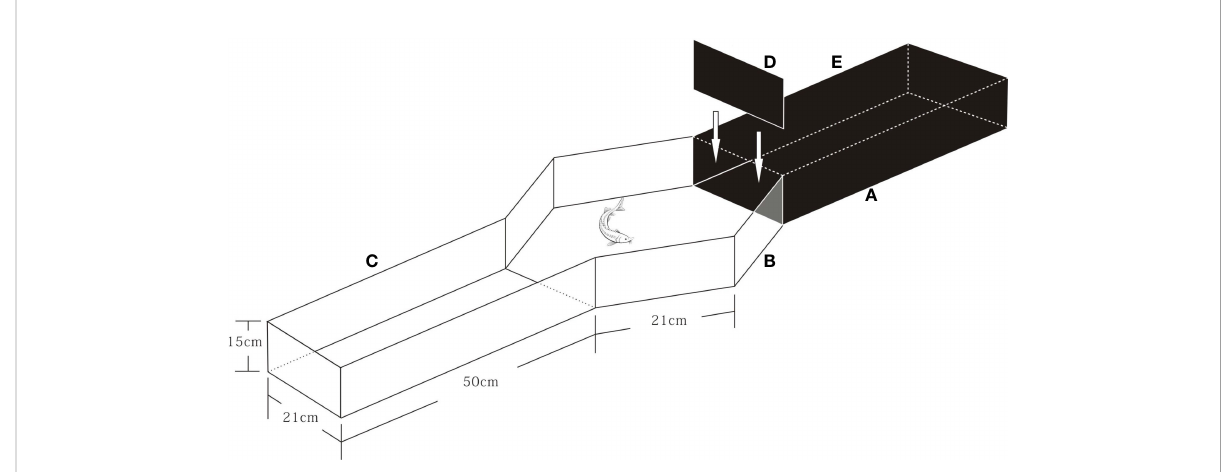
FIGURE 1 Experimental apparatus for testing fi sh personality. The device was divided into 3 parts: (A) is a cuboid dark area (length×width×height = 50cm×21cm×15cm), equipped with a black opaque lid (E) and an opaque baf fl e (D) ; (B) is a hexagon lit area (side length = 21cm); (C) is a lit area with the same shape as